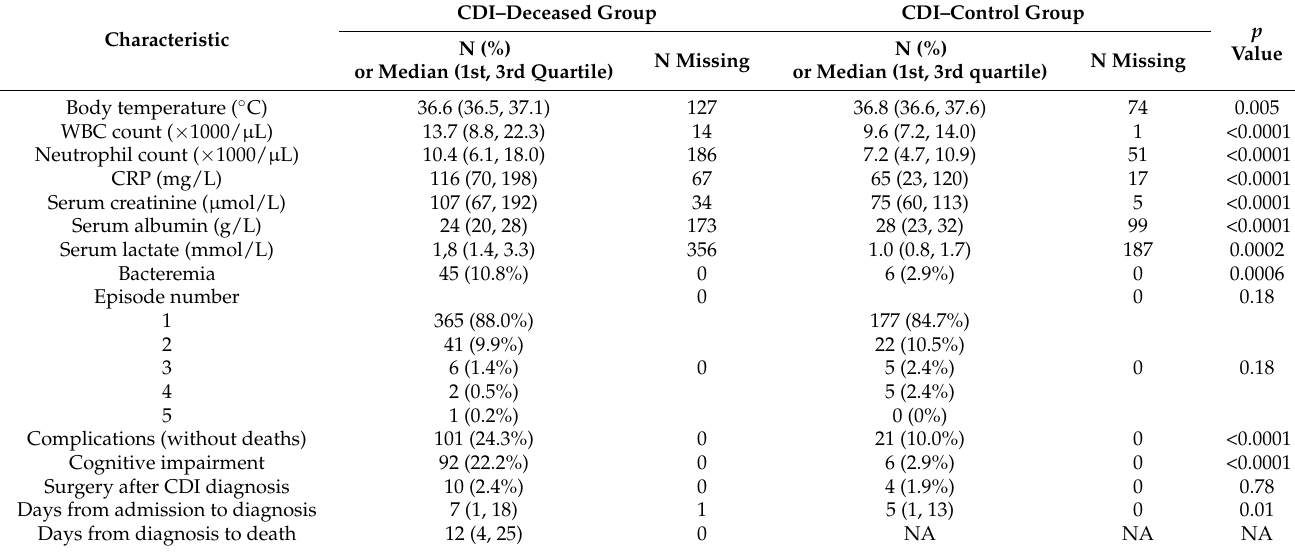
Table 4. Data pertaining to the clinical course of